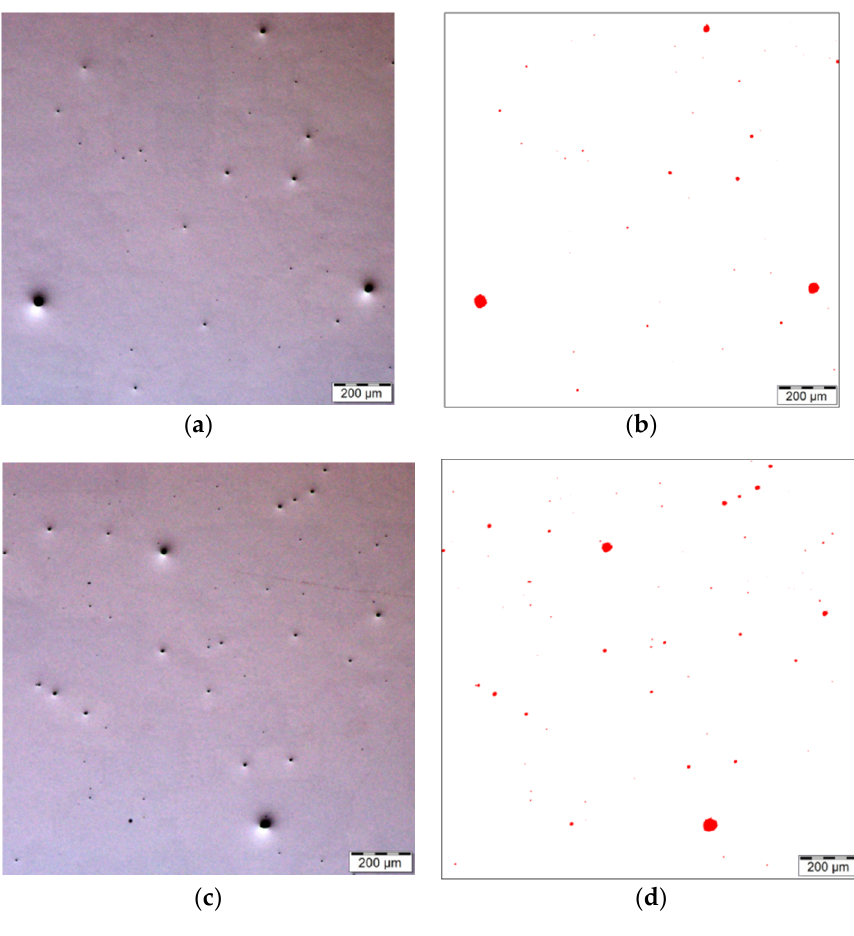
Figure 6. Light optical microscopy (LOM) images show porosity in the XY plane ( a , b ) and in the YZ plane ( c , d ) for the analyzed material; ( a – d ) correspond to sample 1 presented in Table 3.